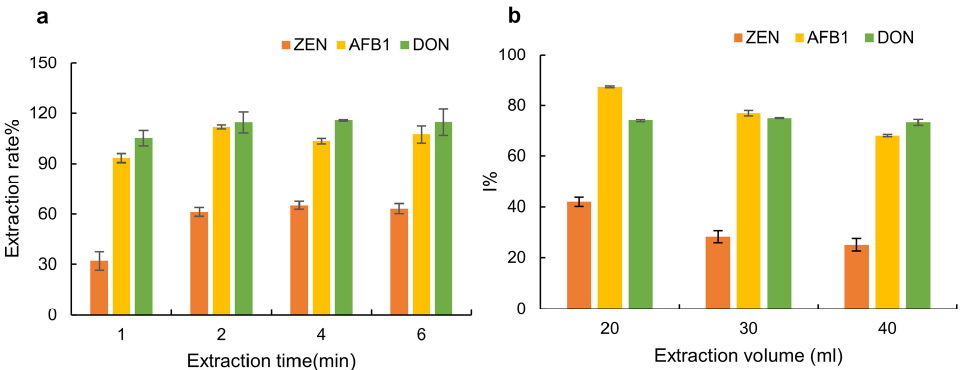
Figure 2. In fl uence on the I% of AFB1, ZEN and DON of ( a ) di ff erent extraction times of 1, 2, 4 and 6min; and ( b ) di ff erent extraction volumes of 20, 30 and